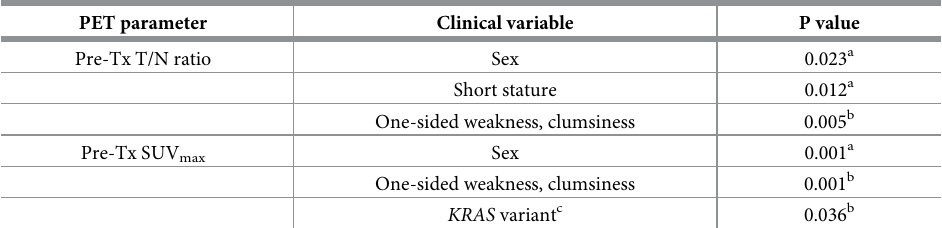
Table 4. Significant differences in PET parameters according to other clinical